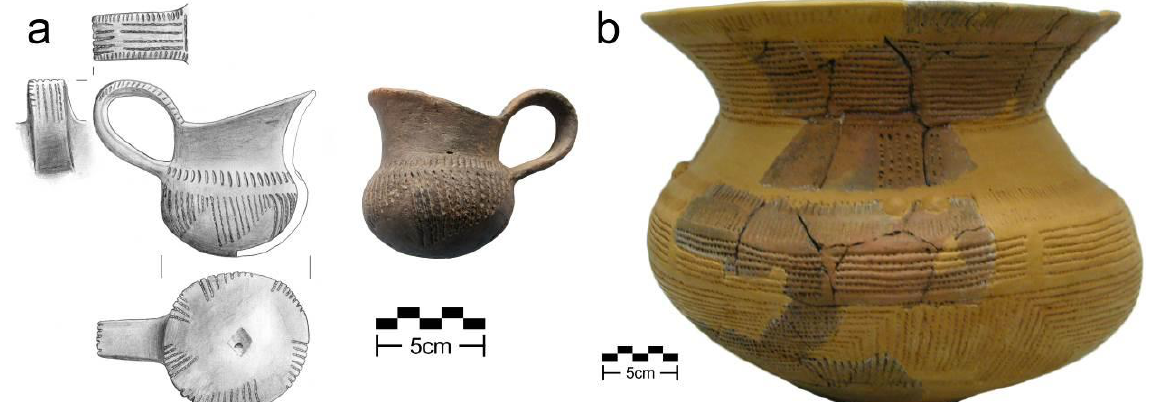
Figure 11. Two examples of a fine quality ceramics found at Piatra Tomii. a) A cup from Section 1. b) A pot from Section